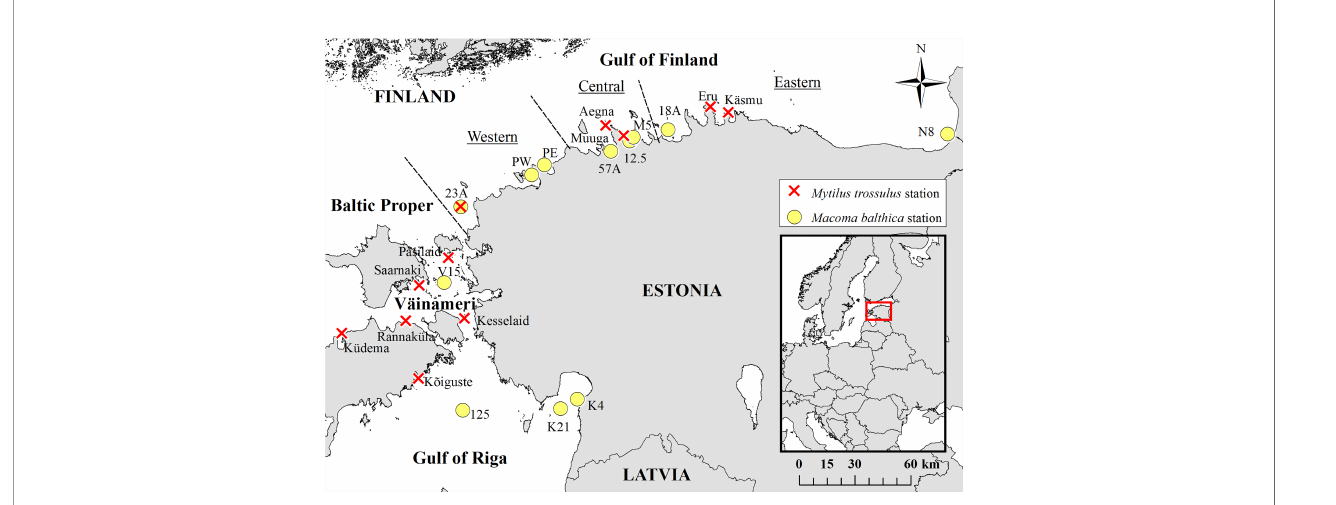
FIGURE 1 | Location of study